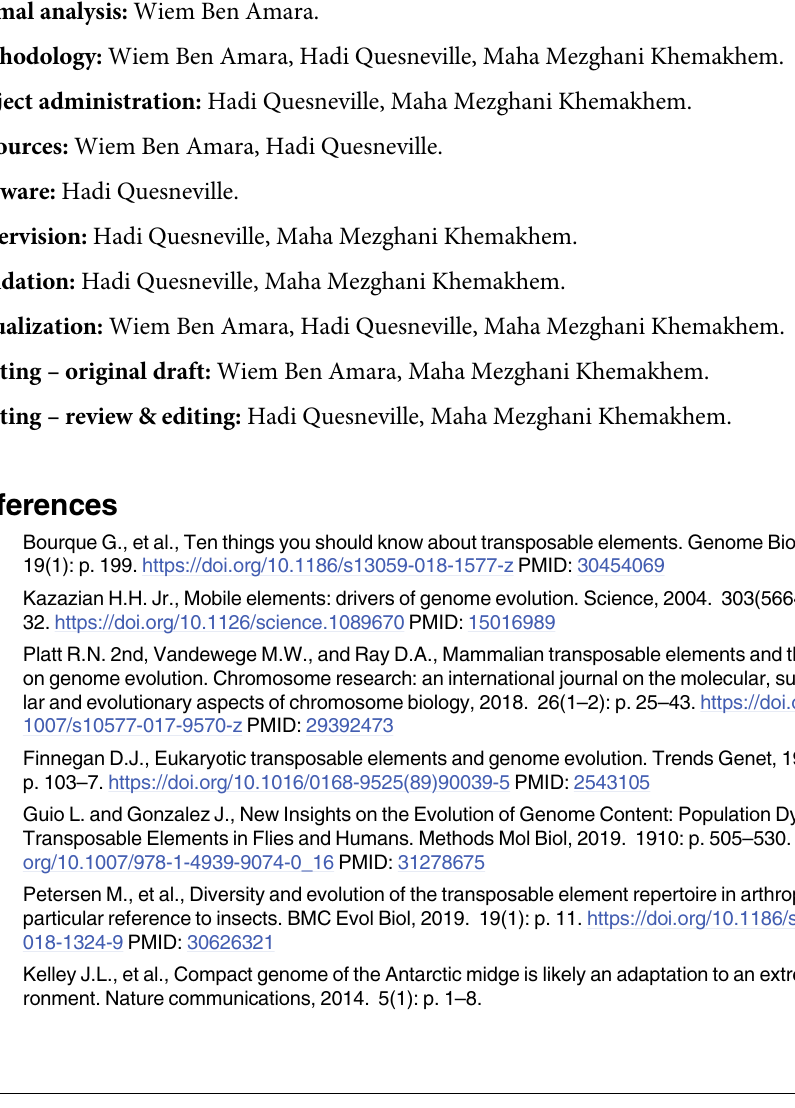
S10 Fig. Phylogeny of Maverick / Polintons elements of Mayetiola destructor . The consen- suses identified in Mayetiola destructor are marked by triangles. Bootstrap values less than 50% are eliminated. The tree is built by the ML method (model HKY85) with a bootstrap of 1000 repetitions. The reference sequences are isolated from the following species: DR: Danio rerio